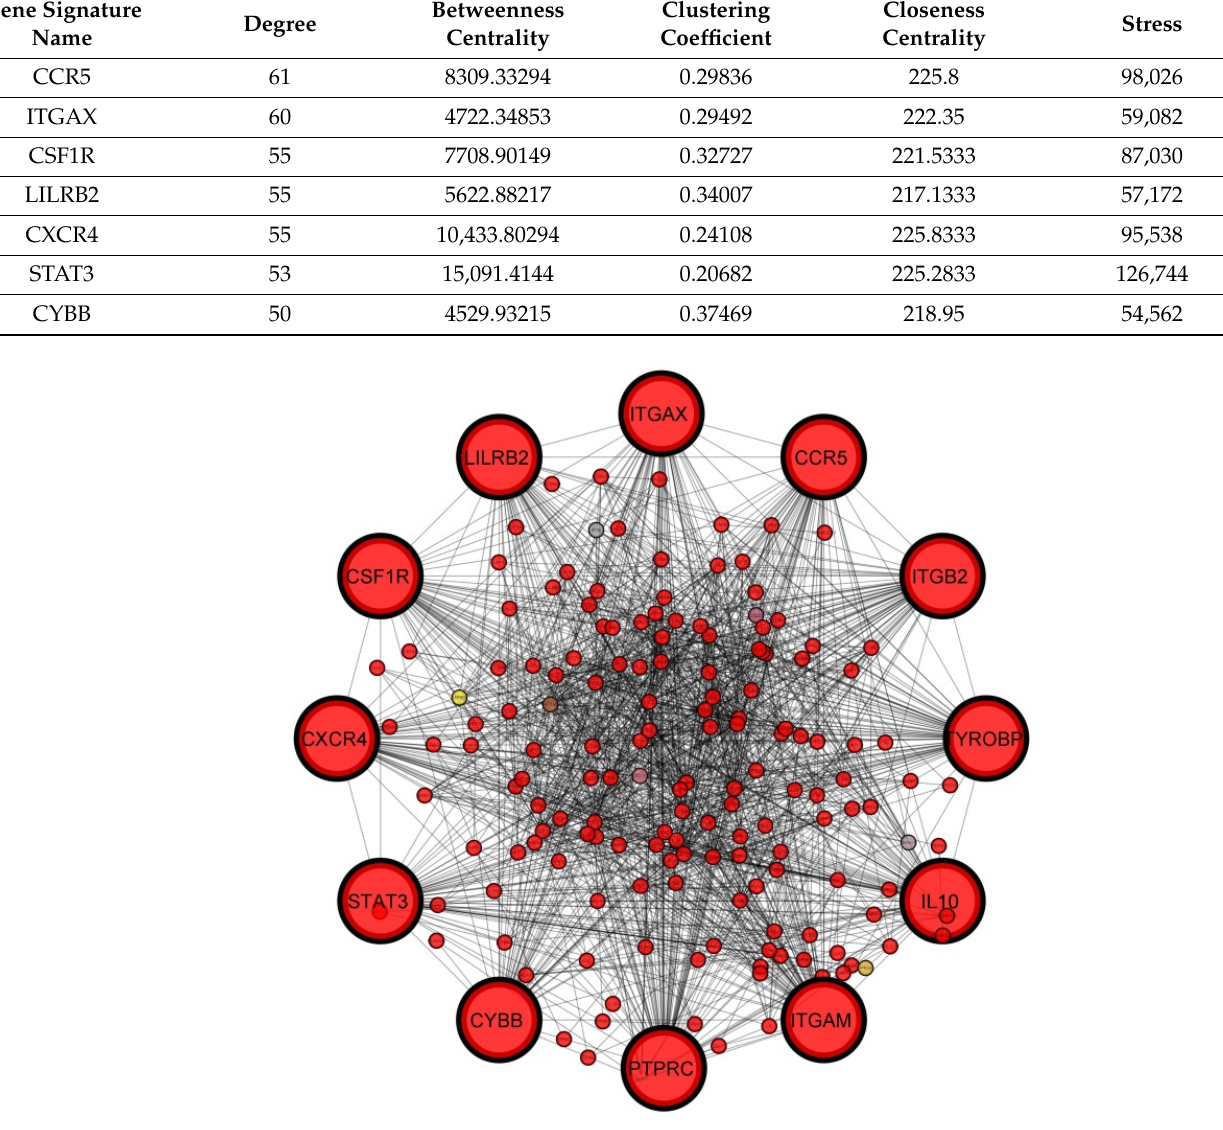
Figure 7. PPI network with identifying hub genes. The highlighted 12 nodes represent the hub genes. The degree score method of cytoHubba considers 94 nodes in this network from the merged PPI network.